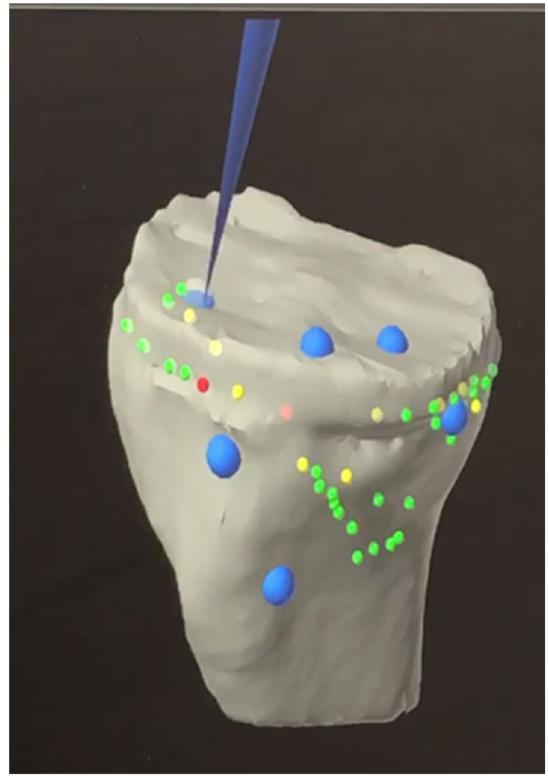
Fig. 6 Tibial bony landmark registration with a total knee tibial